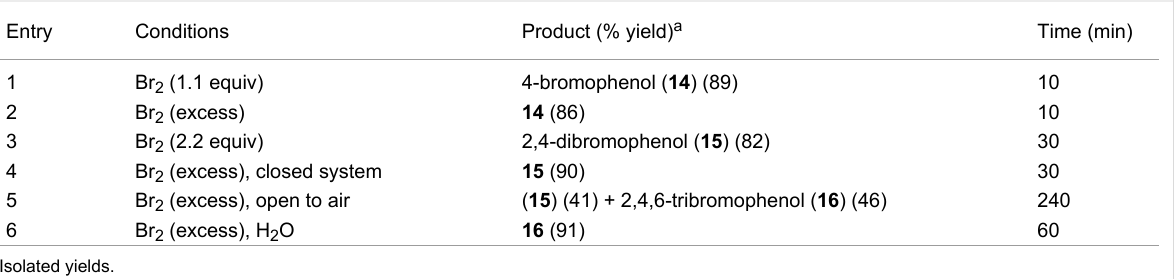
Table 2: Bromination of phenol ( 13 ) under solvent-free PV-PTFE conditions. Entry